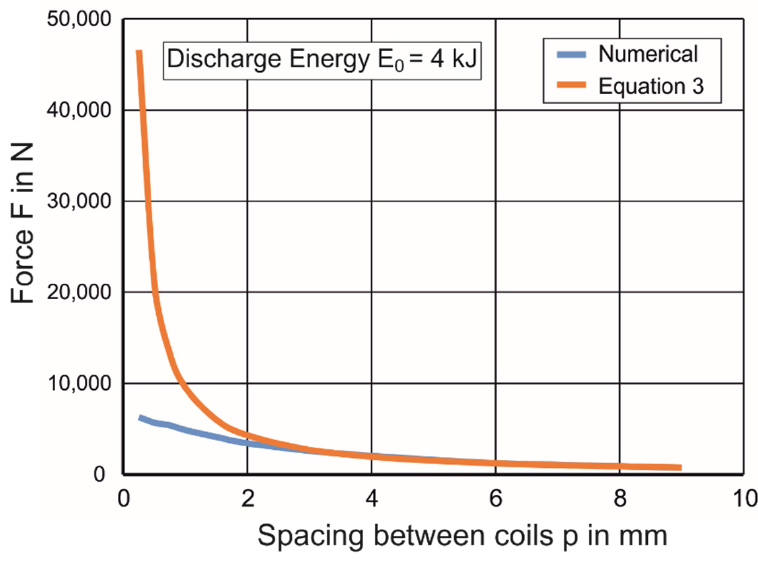
Figure 20. Comparison of total force between two coils predicted by the numerical model in FEMM and the 1/r rule.